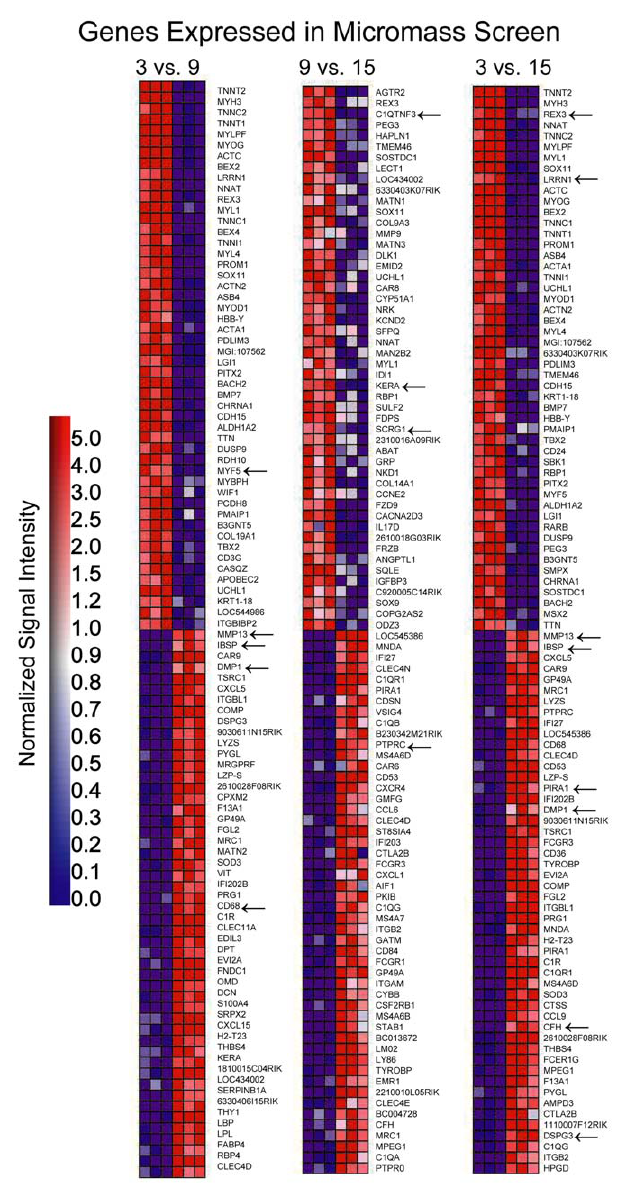
Figure 7. Heat map of micromass culture data set analyzed by GSEA. GSEA-derived heat maps of the top 100 differentially expressed probe sets enriched in micromass data. Correlations between probe sets and day 3 or day 9 of micromass culture for the first map, day 9 or day 15 for the second map and day 3 or day 15 for the third map are shown. Expression profiles for all experimental replicates are depicted for each time point. Signal intensities are illustrated by varying shades of red (up-regulation) and blue (down-regulation). Arrows indicate genes common to the corresponding microdissected growth plate zone